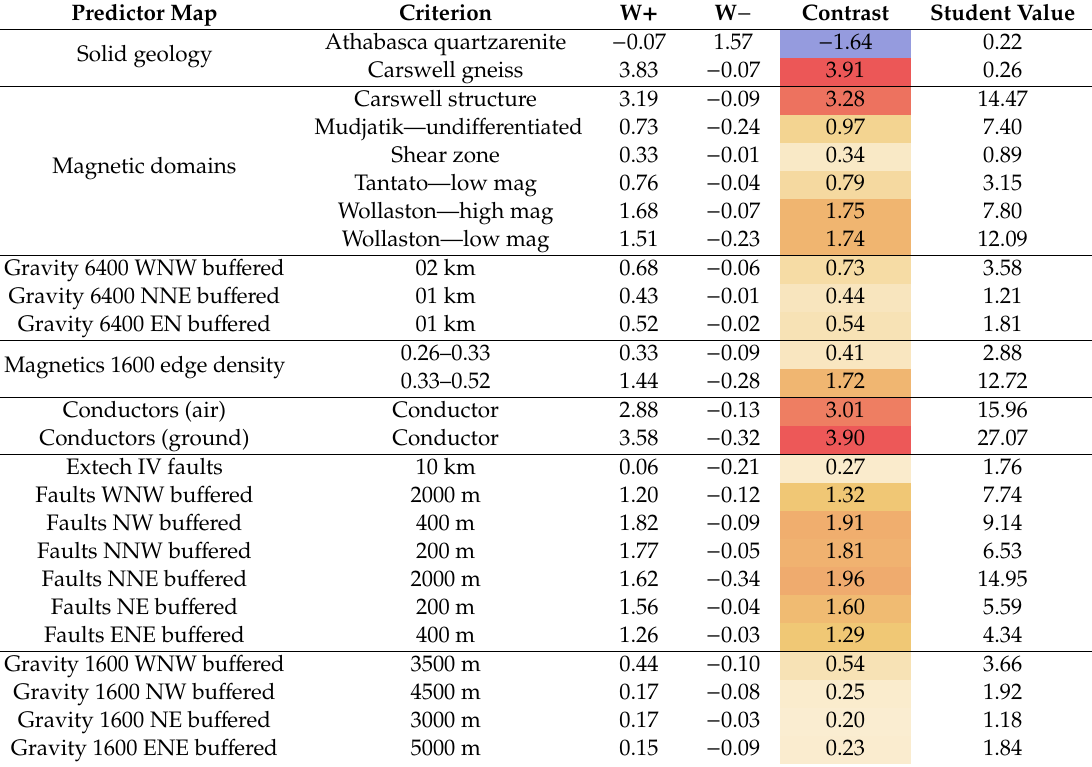
Table 5. Calculated weights of evidence for the Athabasca Basin study, using uranium occurrences as the training set. For multi-class predictors, only features that returned significant contrasts are shown. Where multi-ring bu ff ers have been used around features, the bu ff er with the highest contrast is shown. W + = positive weight of evidence, W − = negative weight of evidence. The contrast is the di ff erence between the positive and negative weights. A positive or negative contrast signifies a net positive or net negative spatial association respectively. Higher contrast values are highlighted by warmer coloured (orange to red) shading and negative contrast values are highlighted by cooler colours (blues). The student value is an approximate ‘Student t test’, and provides a measure of the statistical validity of the contrast. A student value of ‘2’ equates to a 98% confidence level in the calculated contrast; a student value of ‘1’ equates to an 85% confidence